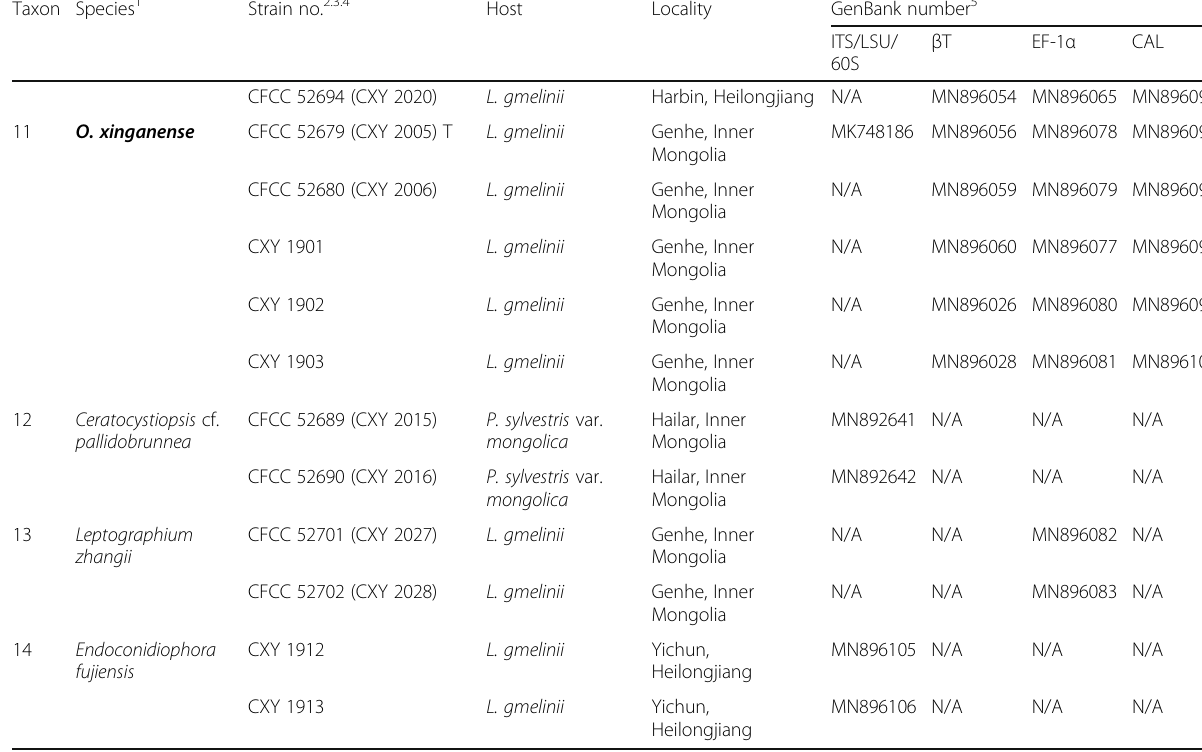
Table 1 Strains of ophiostomatoid fungi sequenced and used for morphological and phylogenetic analysis in this study (Continued) Taxon Species